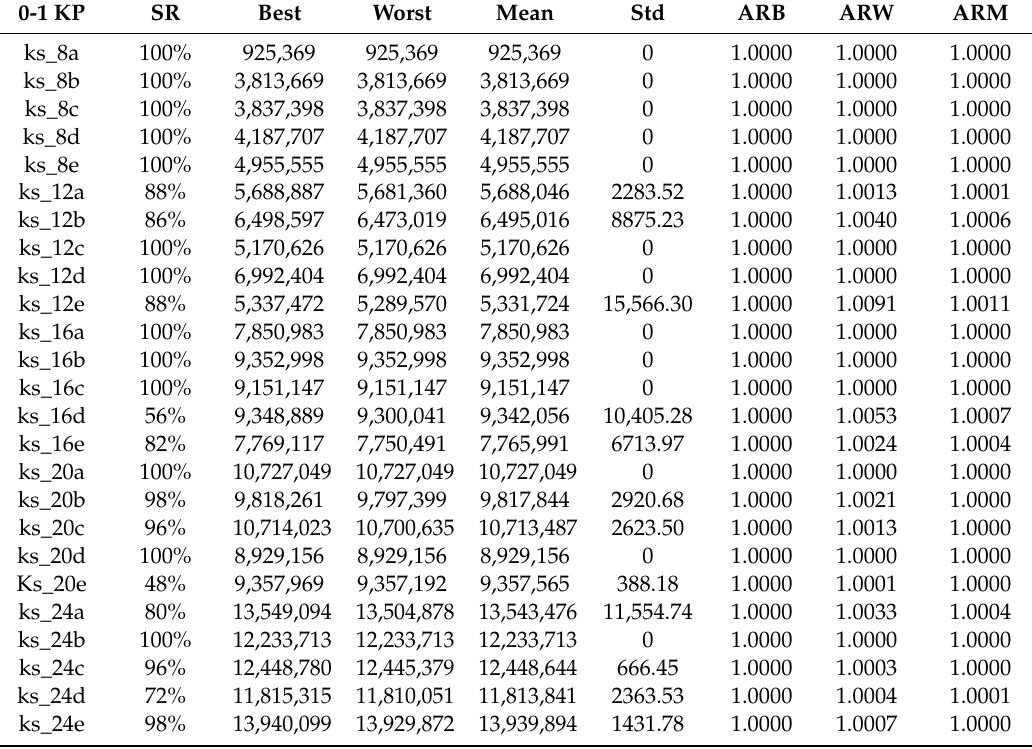
Table 7. The experimental results of 25 low-dimensional 0-1 KP instances obtained by